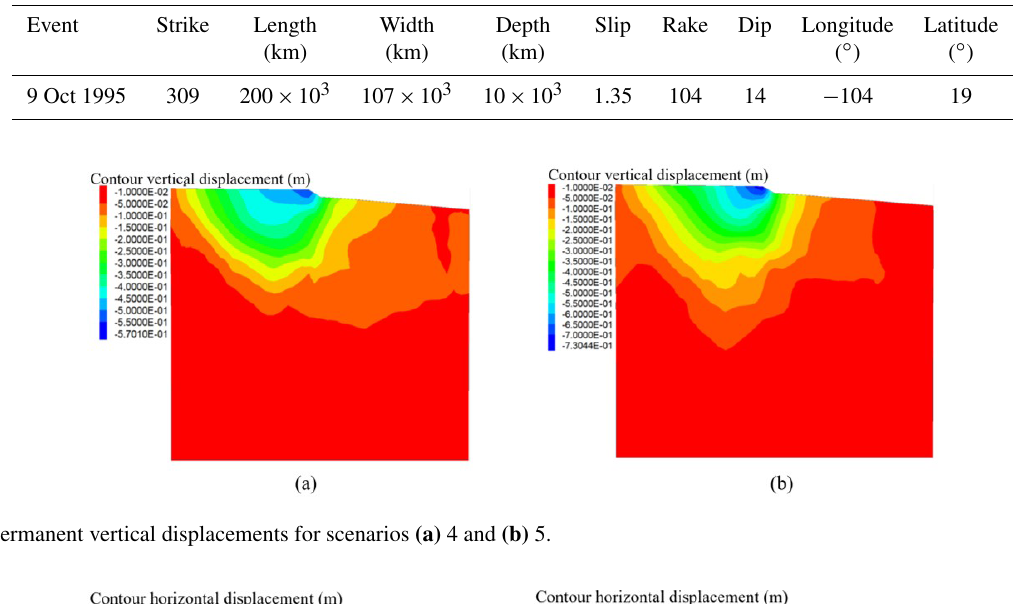
Table 9. Fault characteristics of the 1995 Manzanillo earthquake.